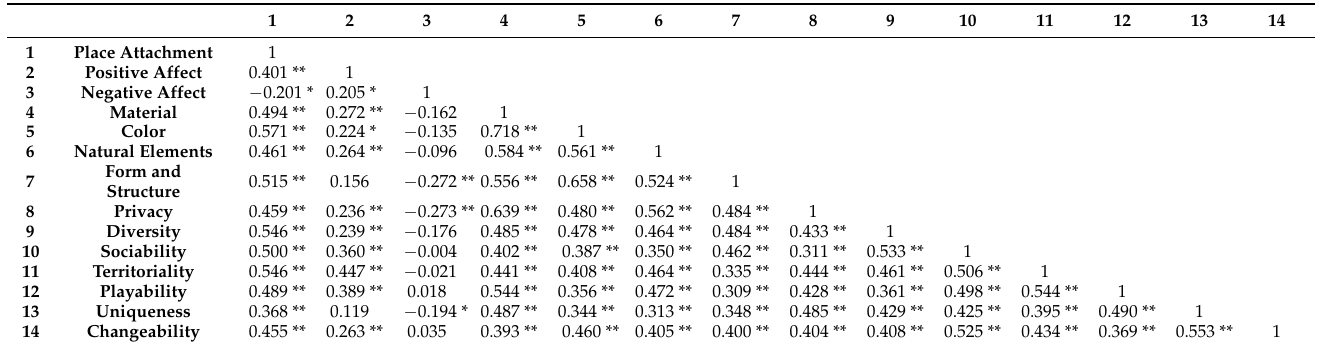
Table 4. Correlation coefficients between different attachment indicators of THE NEW Xidan Re- newal Field.